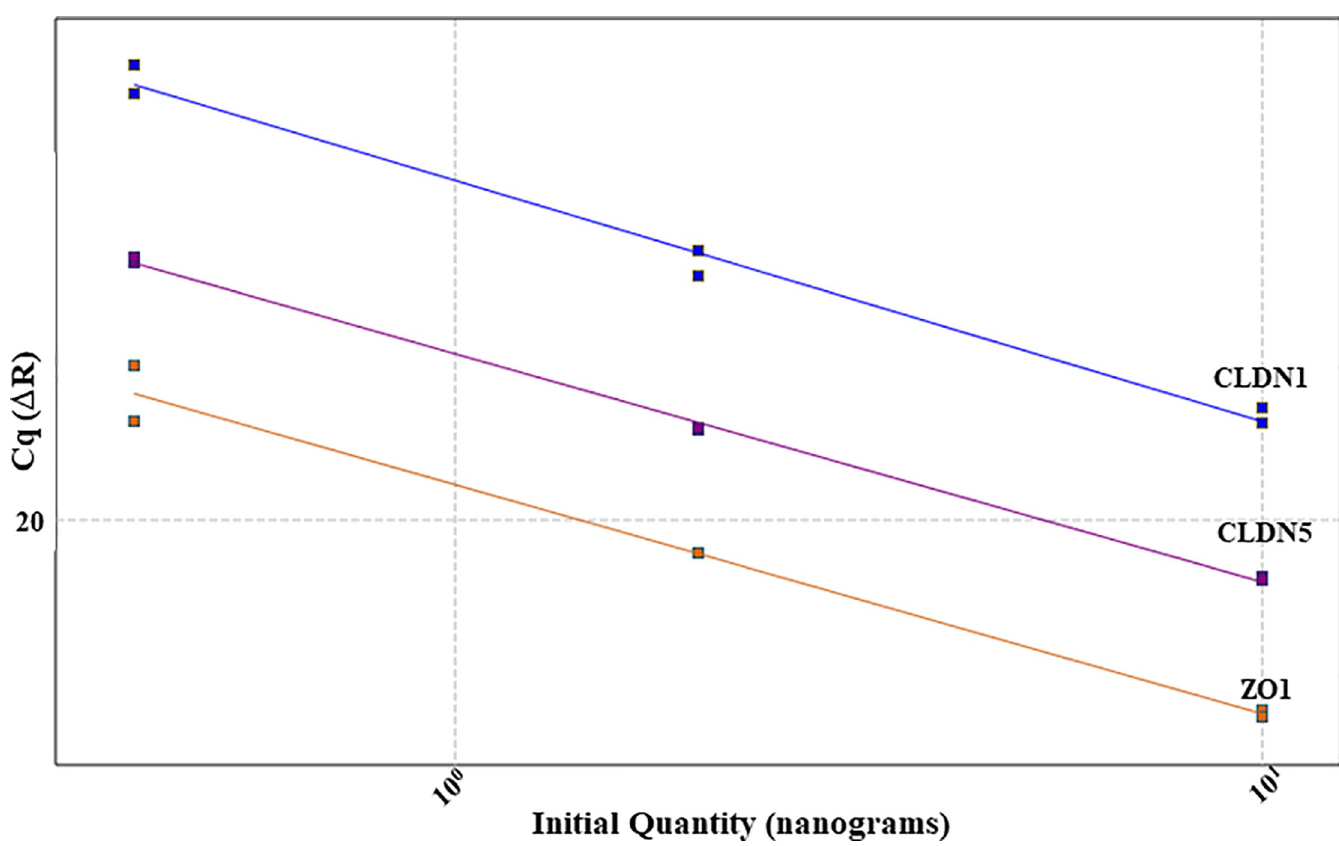
Fig 4. Standard curve of CLDN1, CLDN5 and ZO1. The primers of CLDN1, CLDN5 and ZO1 are forming parallel linear standard curves in a 3x serial dilution enabling accurate quantification of three different target genes in one RT-qPCR run.